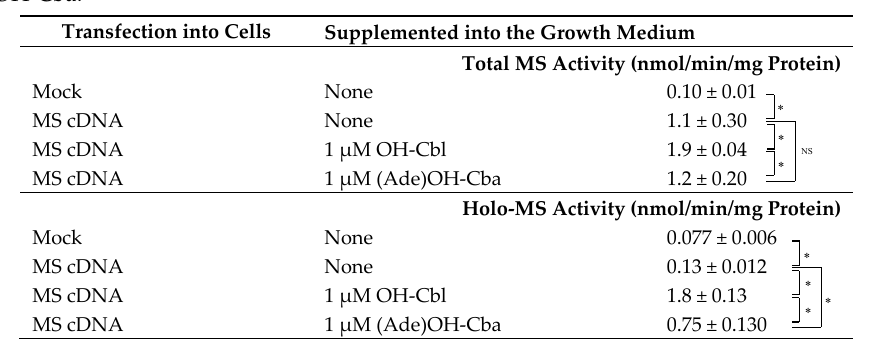
Table 2. Total and holo-MS activity in MS cDNA-transfected cells grown with or without OH-Cbl and (Ade)OH-Cba.